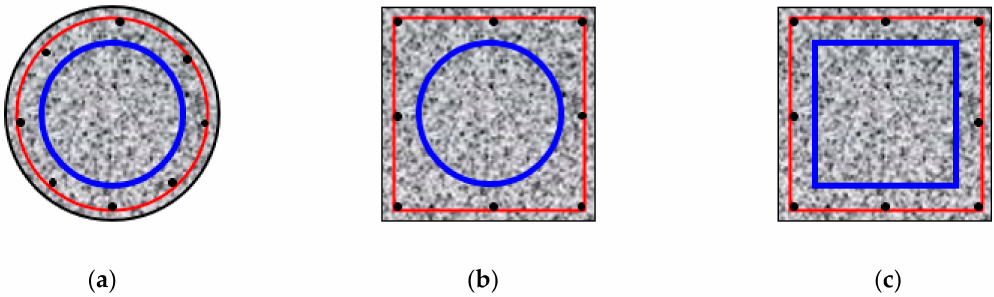
Figure 1. Section types of ST-RC columns ( a ) Circular section; ( b ) Square section;( c ) Square-cased square